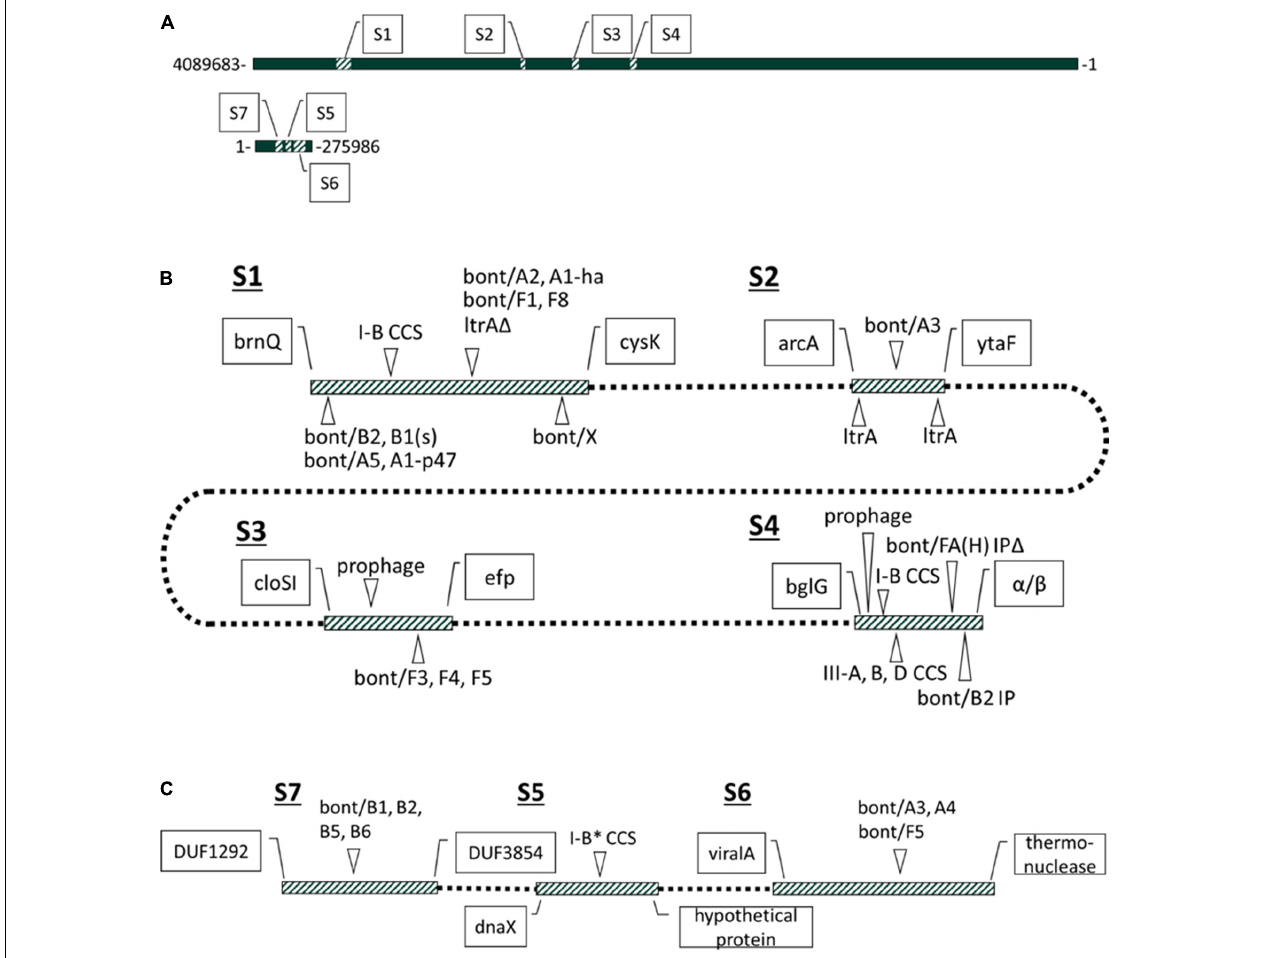
FIGURE 3 | Discrete localization sites of bont gene cluster and CRISPR-Cas systems in C. botulinum and C. sporogenes . (A) Genomic locations of seven specified sites associated with cas and bont gene cluster in G1 C. botulinum and C. sporogenes host diverse MGEs. Sites annotated within the C. botulinum CDC_1436 genome. (B) Strain variable bont , cas , and MGE associated features of the four chromosomal sites known to harbor with bont and cas gene clusters. At S1, a fragment of the group II intron ( ltrA (cid:49) ) intron-encoded protein co-occurs with bont gene clusters integrated at the arsC gene. (C) Plasmid sites associated with bont and cas gene clusters. Boundaries defined for all sites in 43 strains in Supplementary File 5